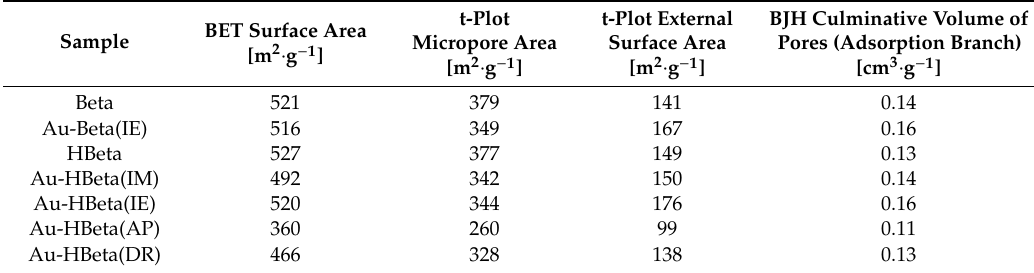
Table 2. Textural properties of investigated